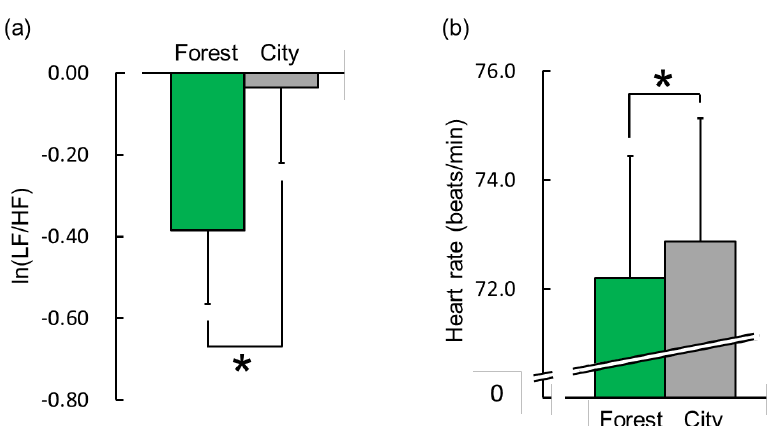
Figure 5. Indicators of sympathetic nervous activity and heart rate during exposure to the forest vs. city sounds for 60 s. ( a ) The overall mean natural log of the low-frequency to high-frequency power ratio of heart rate variability (ln(LF/HF)) and ( b ) overall mean heart rate. Data are expressed as mean ± standard error (n = 29). * p < 0.05 as determined by paired t -test (one sided).